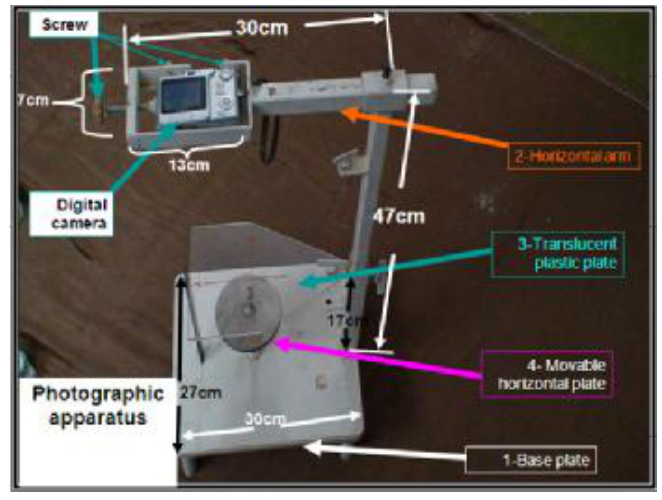
Fig. 1: Photographic Apparatus